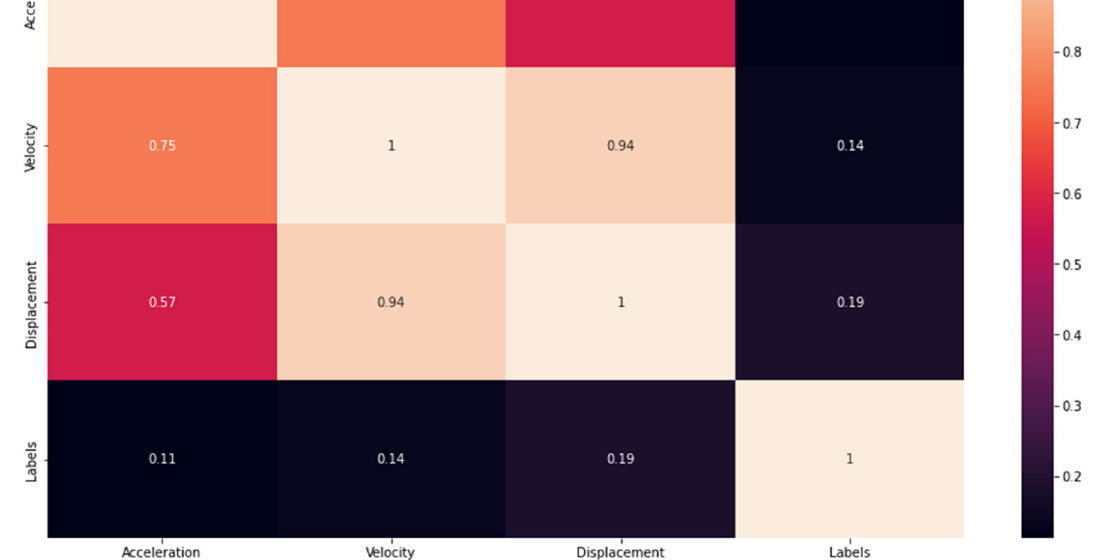
Figure 6. Correlation